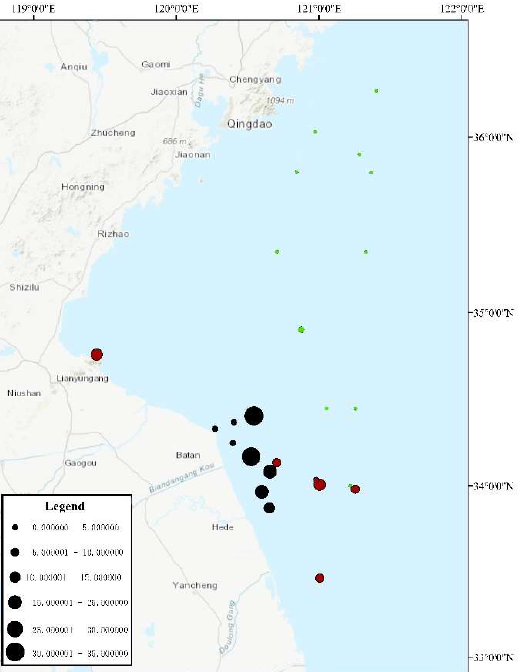
Figure 4. Proportion of U. aragoensis in the micro-propagules. Circle size represents the proportion of U. aragoensis . Different colors represent different sample collection times. Red represents samples collected from 6 May 2021 to 9 May 2021, black represents samples collected from 14 May 2021 to